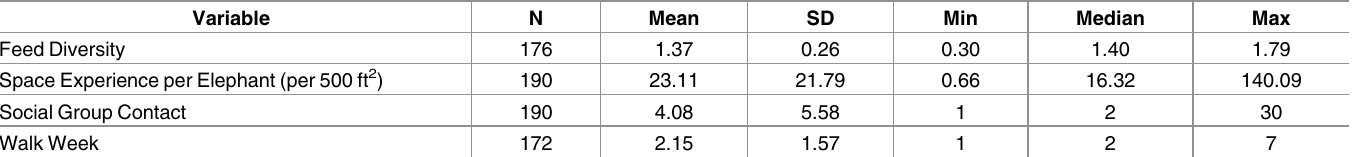
Table 12. Descriptivestatistics for variables in the leptin model.